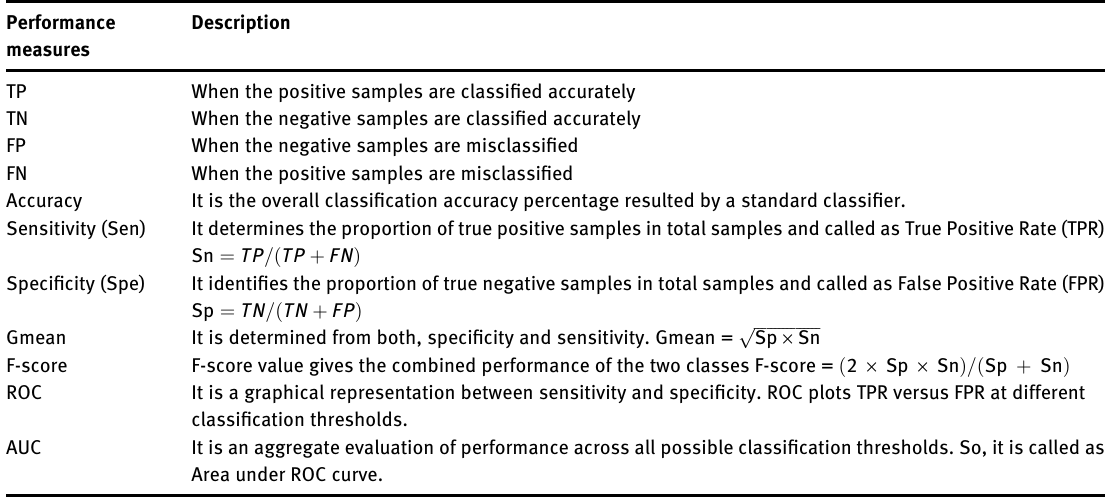
Table  : Detail descriptions about the performance